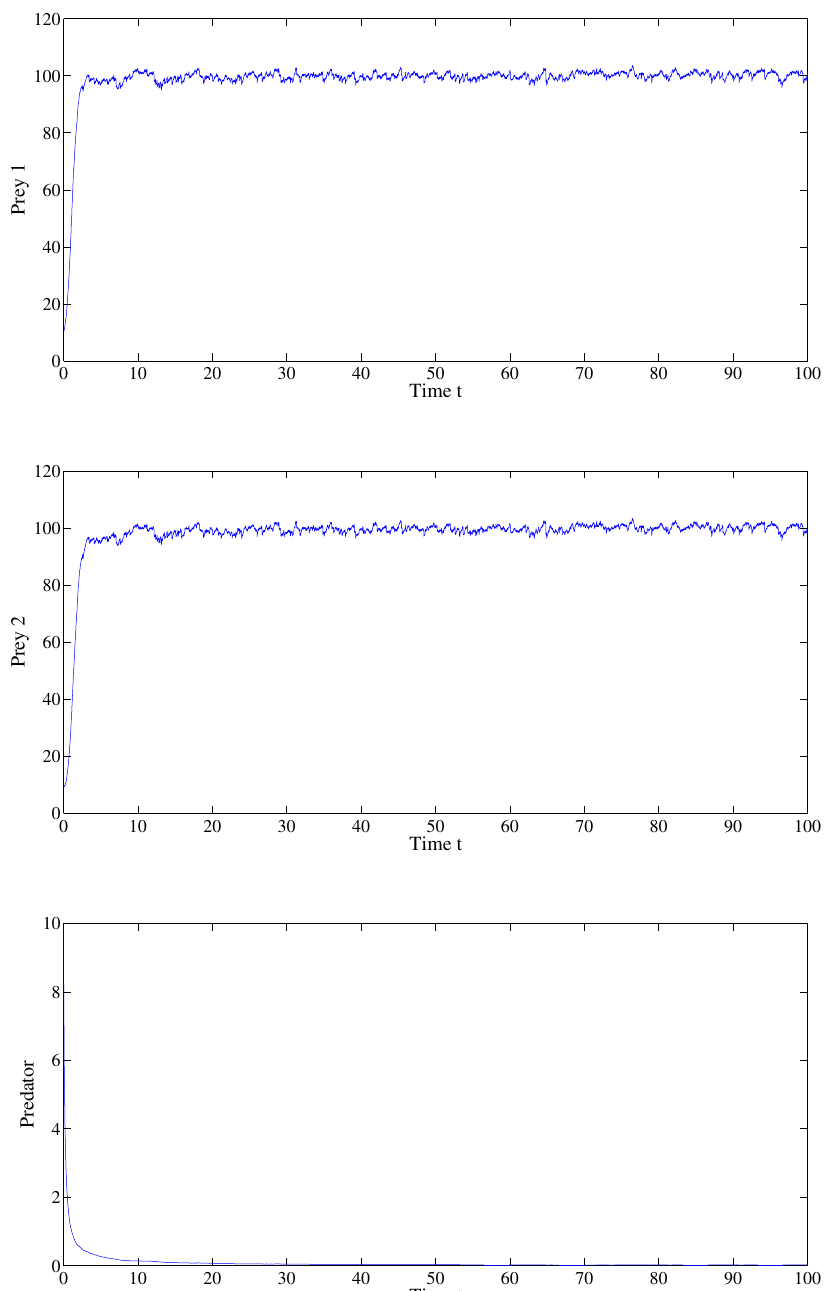
Figure 2. The behavior of the prey and predator populations in the extinction–persistence situation described by Theorem